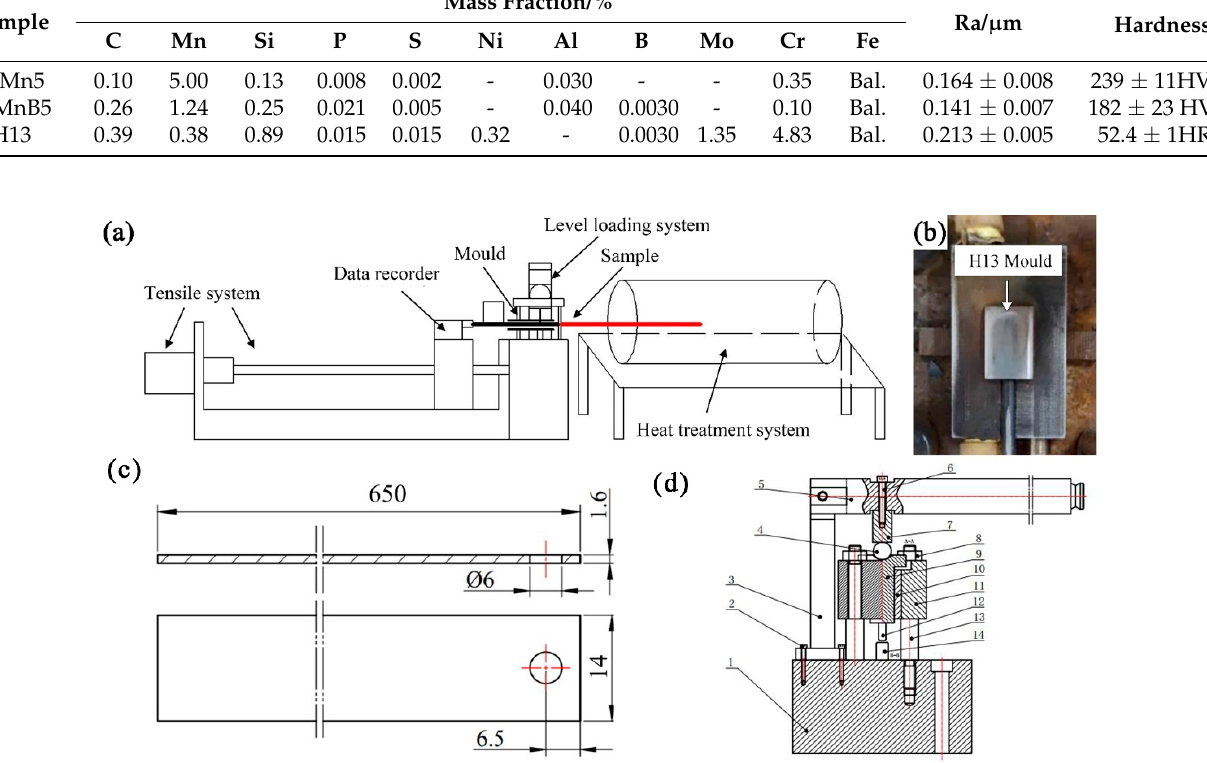
Figure 2. ( a ) Schematic representation of the custom-designed high-temperature sliding-on-sheet- strip tribo-tester, ( b ) H13 Mold on the SOSS tribo-tester, ( c ) schematic diagram of high-temperature friction sample, ( d ) lever loading system 1: base; 2: screw; 3: lever support, 4: force direction adjust- ment ball; 5: lever; 6: screw; 7: stressed cylinder; 8: nut; 9: adapting piece; 10: linear bearing; 11: positioning plate; 12: upper mold; 13: support pillar; 14: lower mold; 15: straight pin. Table 1. Chemical composition and roughness of 10Mn5 steel, 22MnB5 steel and H13 steel. The SOSS tribo-tester was used to conduct unidirectional wear tests on 10Mn5 and 22MnB5 steel. This equipment consists of a heat treatment system, a lever loading system, a friction system and a sample moving system, as shown in Figure 2a. The machine is also equipped with a cooling channel, which can cool the sample rapidly, to simulate the actual hot rolling